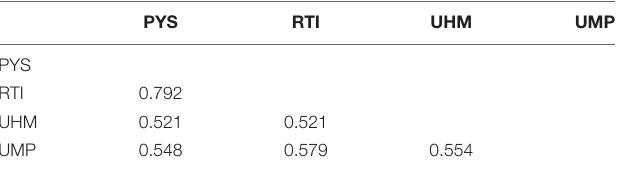
TABLE 5 | A path analysis.